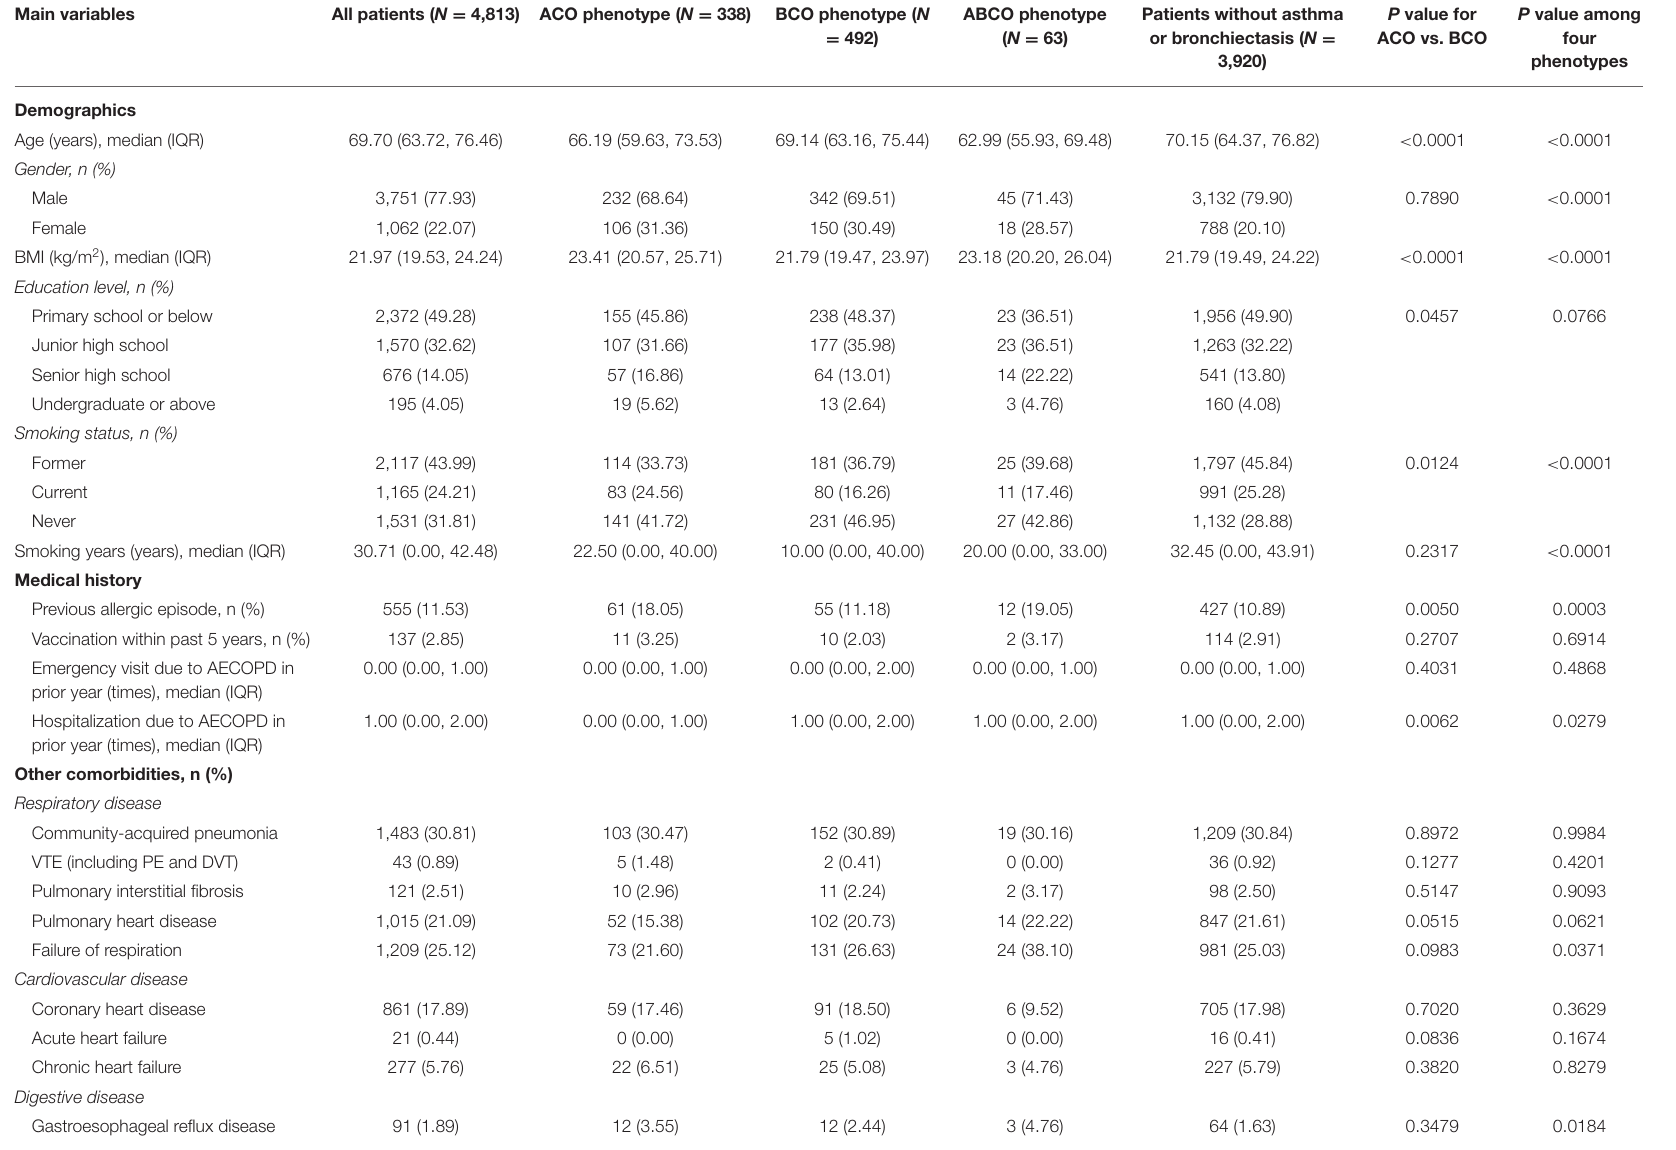
TABLE 1 | Main characteristics and comparisons among ACO, BCO, ABCO phenotypes, and those without asthma or bronchiectasis in hospitalized AECOPD patients. Main